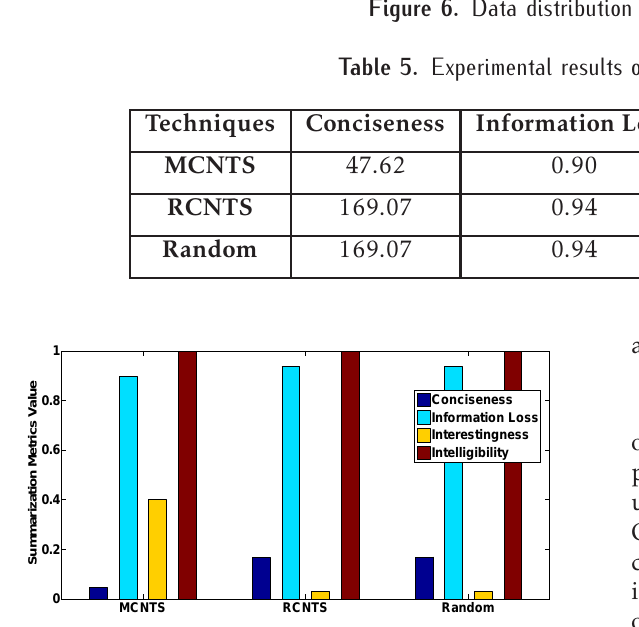
Figure 7. Comparison among the summarization